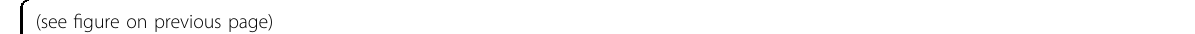
Fig. 6 Klf2 regulates i NKT cell migration and differentiation. a Representative fl ow plots of thymic i NKT cells from Klf2 KO and WT mice (left); bar graphs represent means ± SD of frequency and cell number (right), n = 3 for Klf2 KO and WT controls. Data represent two independent experiments. b Representative fl ow plots of different stages (stage 0: CD24 + ; stage 1: CD44 lo NK1.1 − ; stage 2: CD44 hi NK1.1 − ; stage 3: CD44 hi NK1.1 + ) of i NKT from Klf2 KO and WT mice (left); bar graphs represent means ± SD of frequencies and cell numbers of different developmental stages of i NKT cells in Klf2 KO and WT controls (right). c , d Representative fl ow plots of peripheral i NKT cells from Klf2 KO and WT mice. Bar graphs represent means ± SD of frequencies and cells numbers of i NKT cells in indicated organs from Klf2 KO and WT controls. Data represent two independent experiments. e Histogram showing CCR7 expression in thymic i NKT cell from WT and Klf2 KO mice. f Bar graph showing mean fl uorescence intensity (MFI) of CCR7 in i NKT cells from WT and Klf2 KO mice. g Representative fl ow plots showing Ki-67 expression in different developmental stages of thymic i NKT cell from WT and Klf2 KO mice. h Histogram showing PLZF, T-bet, and ROR γ t expression in different developmental stages of thymic i NKT cell from WT and Klf2 KO